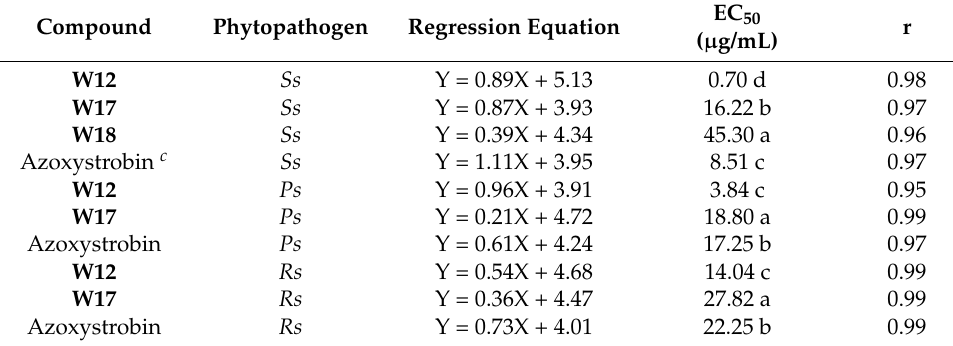
Table 2. EC 50 values of several target compounds a b .